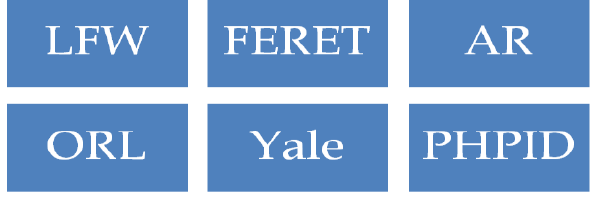
Figure 3 . Datasets containing images of faces